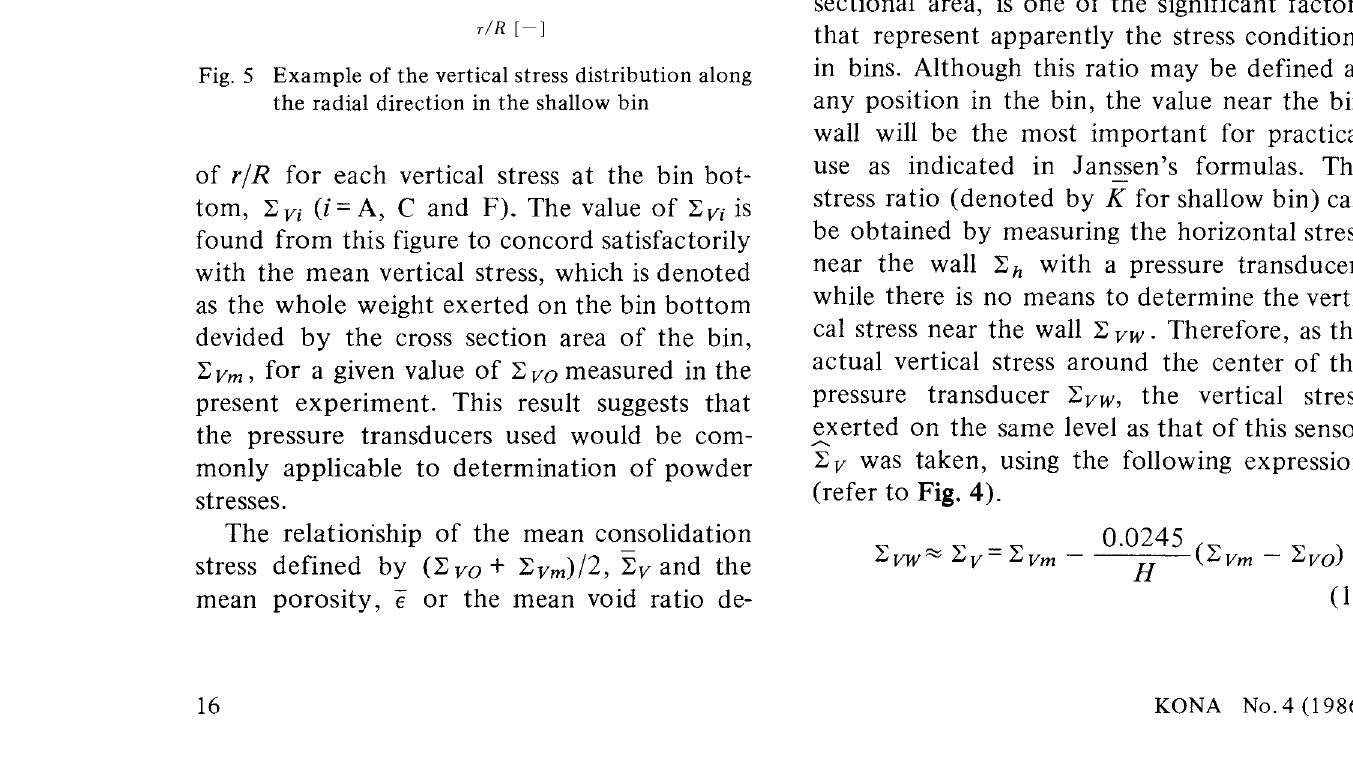
Fig. 6 Relationship between the mean consolidation stress and the porosity or the void ratio in the shallow bin fined by e = f I ( 1 - €) is illustrated in Fig.